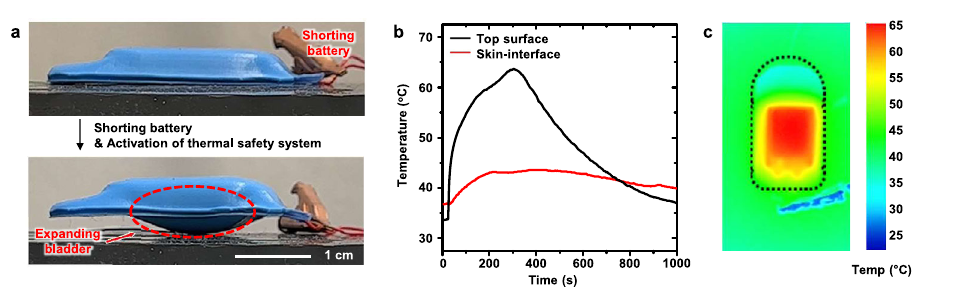
Fig. 5 | Activation of a thermal safety system in a skin-interfaced, wireless mechano-acoustic (MA) sensor. a Activation of the thermal safety system upon